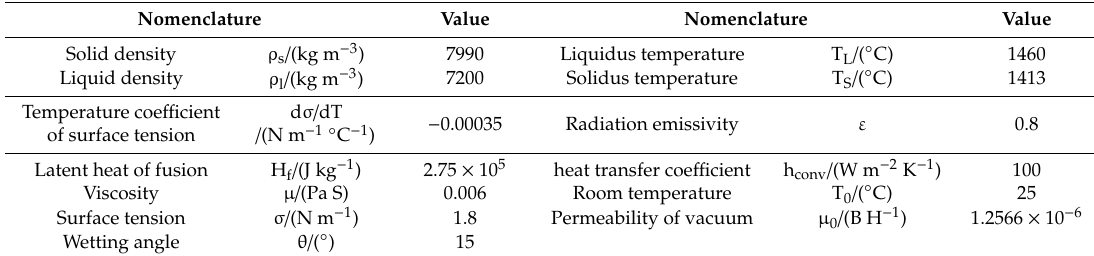
Table 3. Material physical properties employed in the simulation [7].